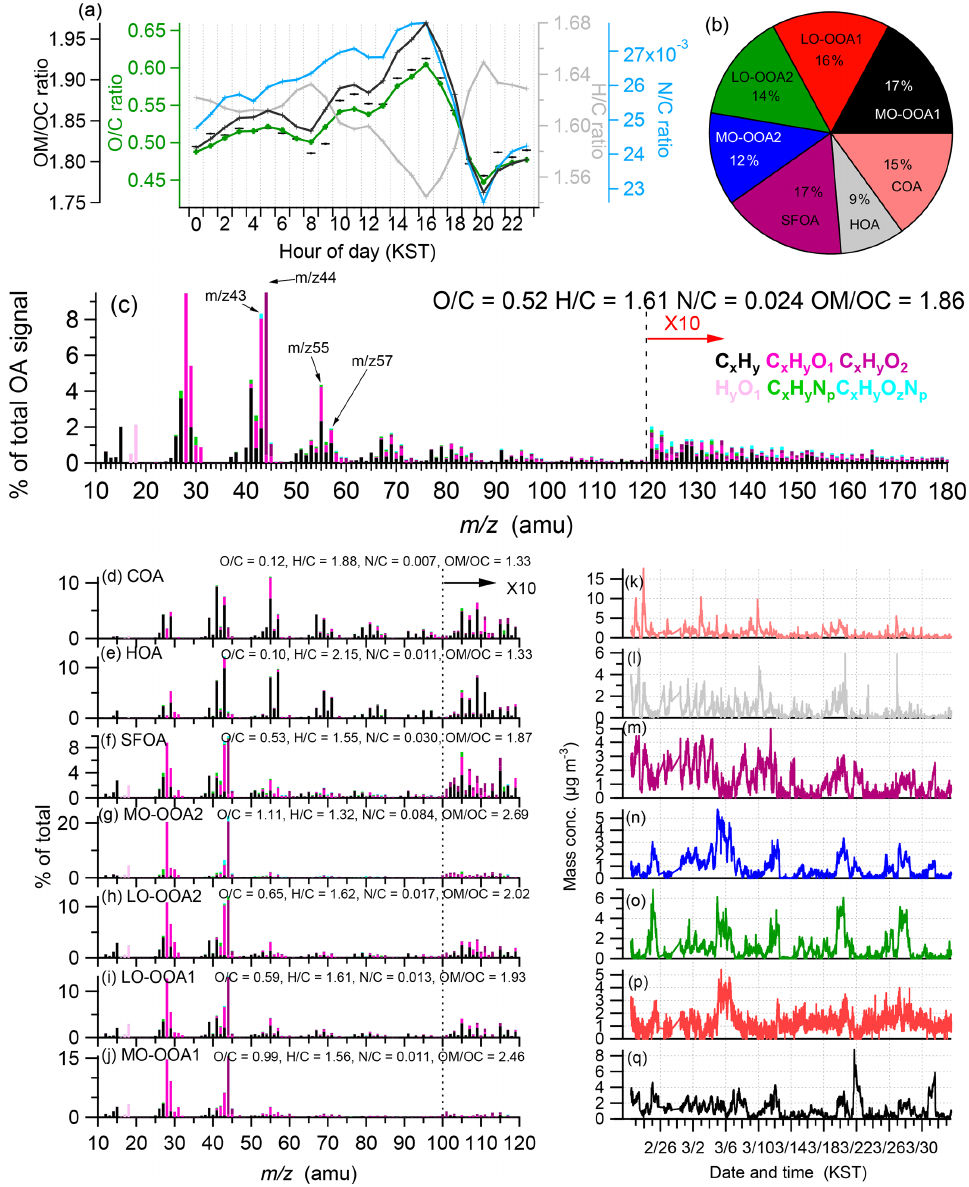
Figure 2. (a) Average diurnal profiles of the organic matter to organic carbon ratio (OM / OC), oxygen-to-carbon ratio (O / C), hydrogen- to-carbon ratio (H / C), and nitrogen-to-carbon ratio (N / C), where the O / C, H / C, and OM / OC elemental ratios were determined using the updated method (Canagaratna et al., 2015); (b) compositional pie chart of the average fractional contribution of each of the factors of the OA to the total OA during the campaign; (c) average high-resolution mass spectra of the OA colored by the different ion families. The average elemental ratios for the fractions of the OA are described; (d–j) high-resolution mass spectra of all organic sources from the PMF analysis including cooking OA (COA), hydrocarbon-like OA (HOA), solid-fuel-burning OA (SFOA), more oxidized OA2 (MO-OOA2), less oxidized OA2 (LO-OOA2), less oxidized OA1 (LO-OOA1), and more oxidized OA1 (MO-OOA1); and (k–q) time series of each organic source from the PMF analysis including COA, HOA, SFOA, MO-OOA2, LO-OOA2, LO-OOA1, and MO-OOA1 (from top to bottom).